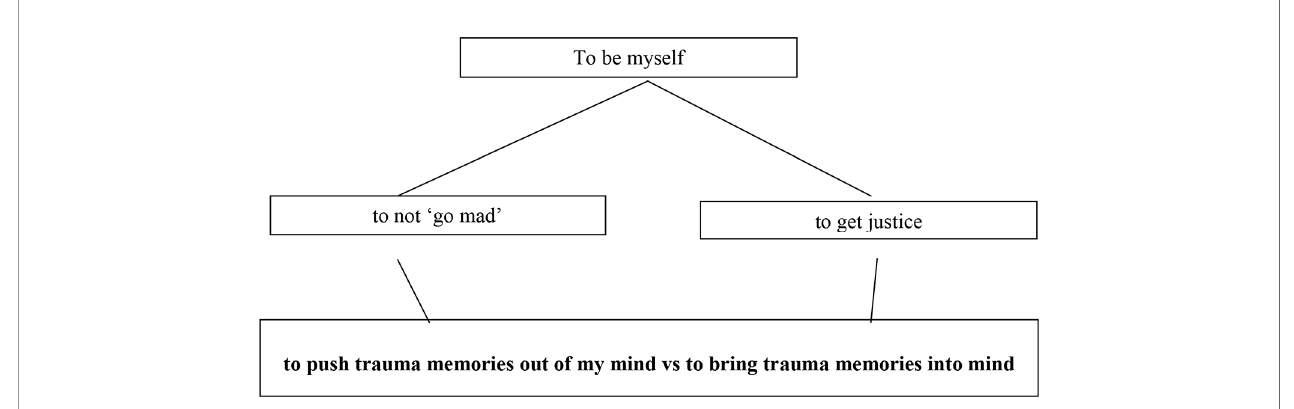
FIGURE 2 | A diagram to illustrate the three levels involved in the loss of control due to unresolved con fl ict according to PCT. The top level contains a single higher level system that sets two or more subgoals at the middle level. These subgoals send out con fl icting references for a low level system that entails loss of control and instability — in this case, the recall and suppression of trauma memories. Note that this model is simpli fi ed — there will be control systems intermediate between the “ mid ” and “ low ” level, such as to “ to be able to describe my trauma ” and “ to be a credible witness ” , as a means to achieve justice through the recall of